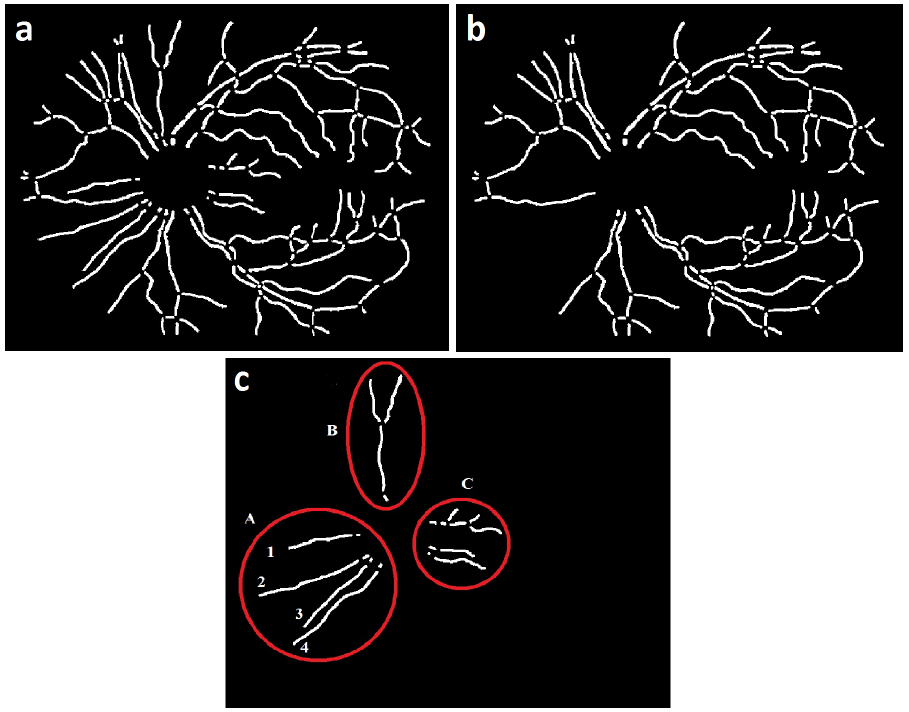
Figure 8. Image example: a) Vessel segment map b) Vessel trees with AV crossing c) Vessel trees without AV crossing.